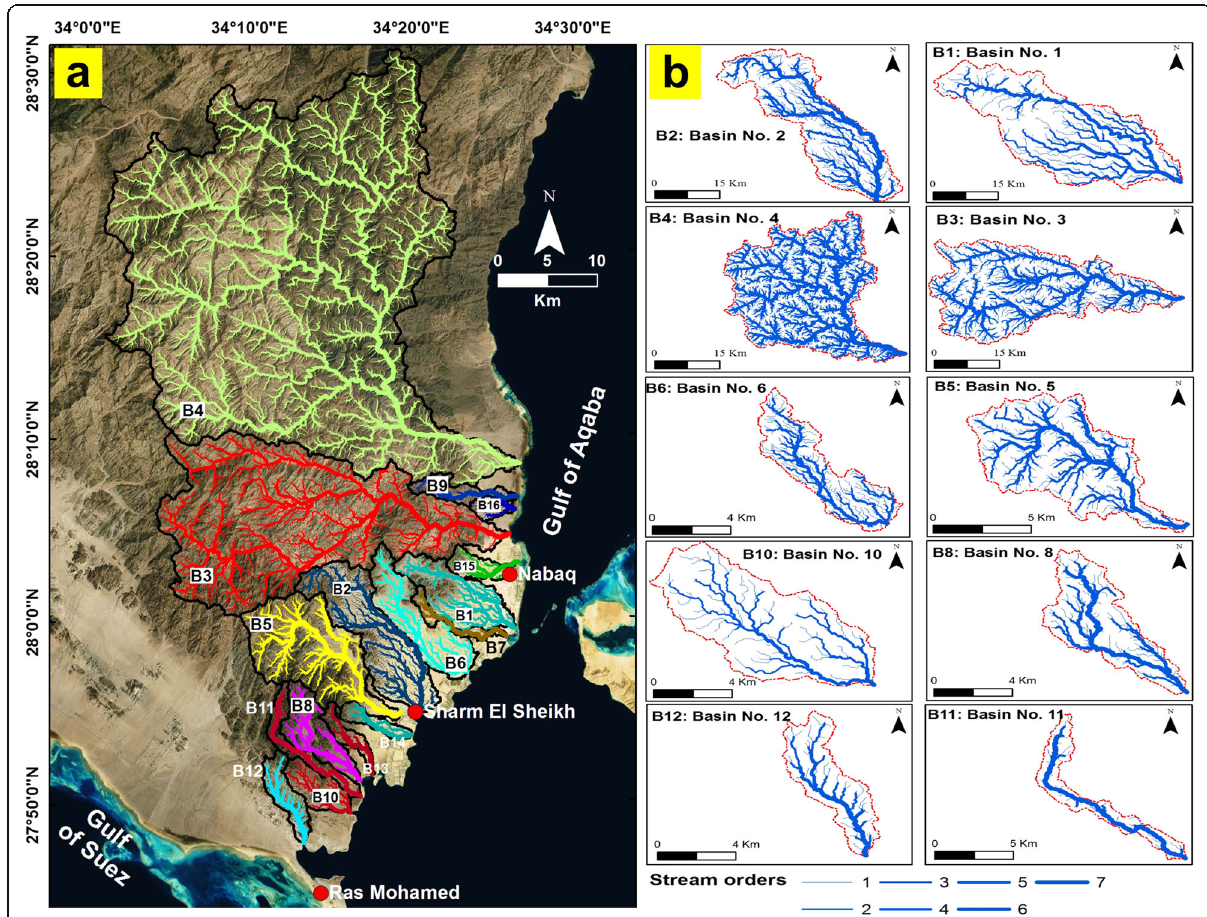
Fig. 11 a Map of the studied 16 hydrographic basins draped over Google earth Tm. b Selected most important 10 basins (largest areas) with their stream